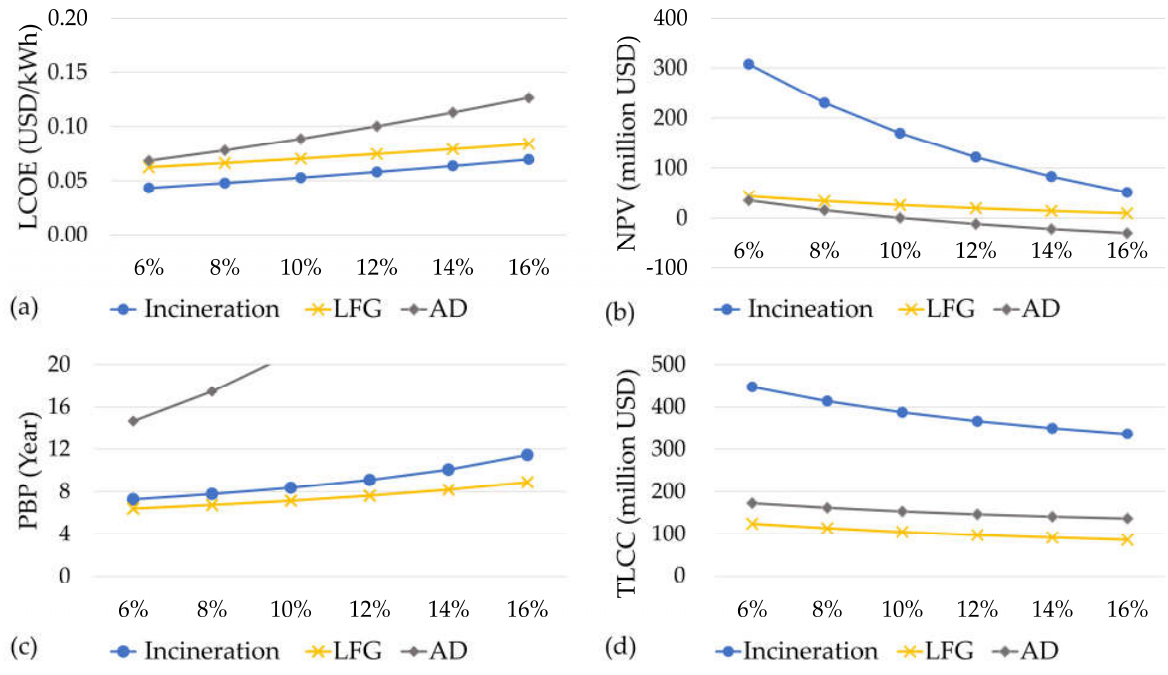
Figure 6. Influence of discount rate on ( a ) LCOE, ( b ) NPV, ( c ) PBP, and ( d ) TLCC .